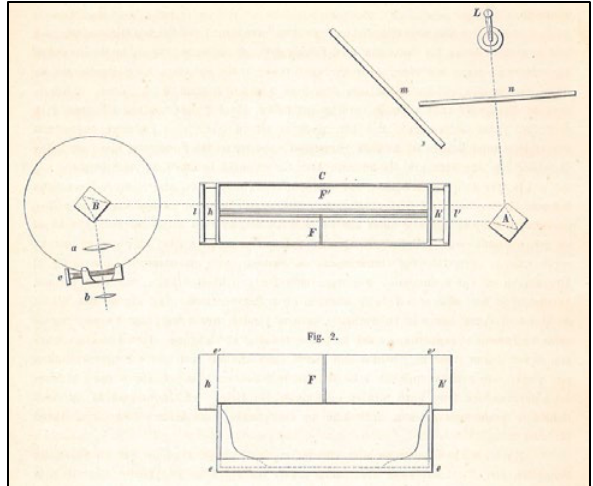
Figure 4. Lorenz’s apparatus of 1869 for the determination of the refractivity-density relationship for liquids. In the tank C a thin tube with the liquid is enclosed between two mirror glasses l and l’. The two parts of the tank F and F’ and the two small containers h and h’ are filled with distilled water. The tank is mounted between two Jamin mirrors B and A formed as cubes. One of the light rays passes the tube while the other ray passes the water in the tank with the result that the interference lines are displaced. By measuring the number of displaced lines and the weight of the liquid Lorenz could relate the refractivity of the liquid to its